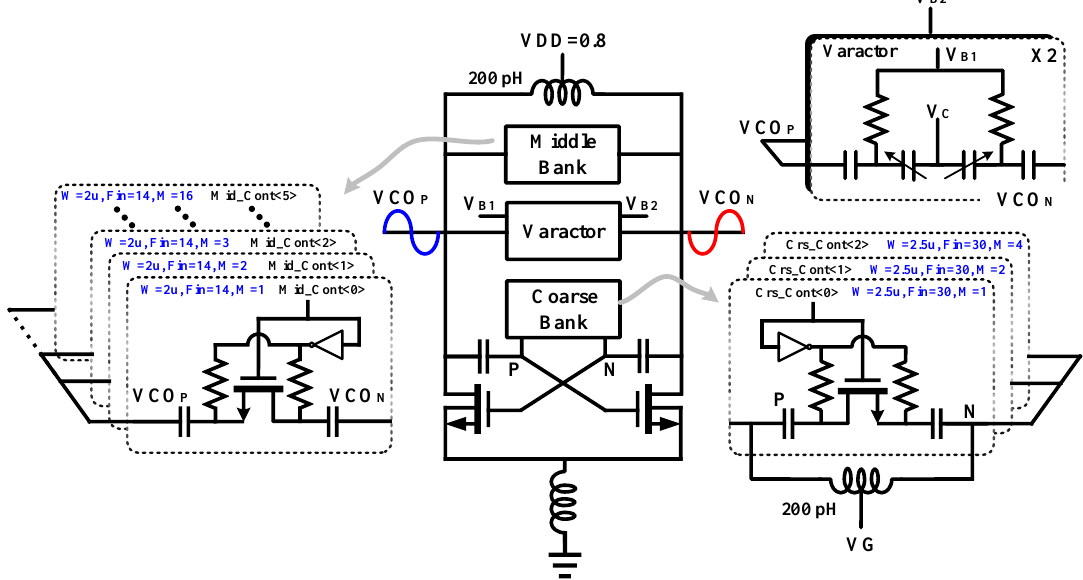
Figure 3. Top block diagram of the proposed linear transconductance voltage controlled oscillator (VCO).